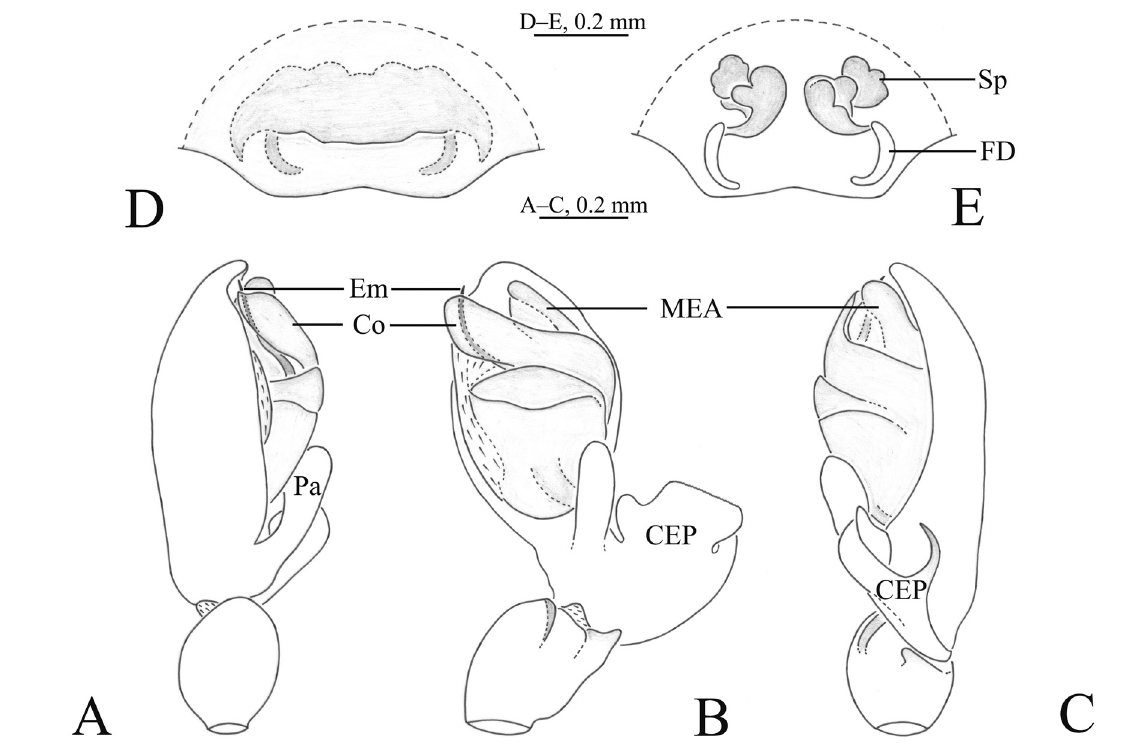
Fig. 16. Meta wanglang sp. nov. A–C . ♂, holotype (SWUC-T-TEg-07-01). D–E . ♀, paratype (SWUC-T- TEg-07-03). A . Left palp, prolateral view. B . Same, ventral view. C . Same, retrolateral view. D . Epigyne, ventral view. E . Vulva, dorsal